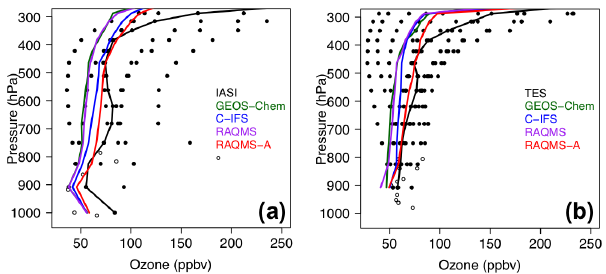
Figure 17. Same as Fig. 14, but for a case study of 10 June